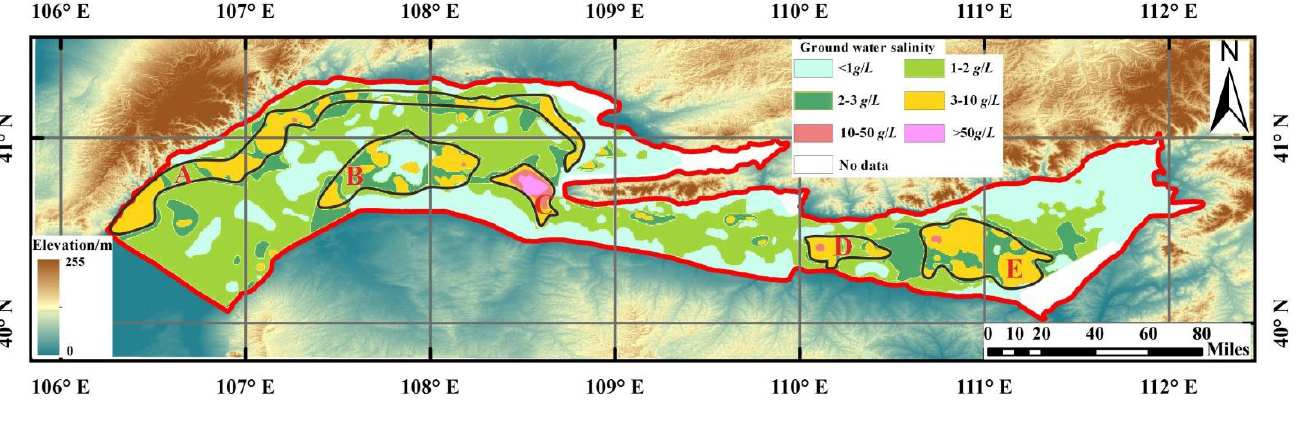
Figure 3. Distribution map of salinity in Hetao Plain. (A — Highly mineralized water distribution zone of valley in front of fan in Houtao Plain; B — Highly mineralized water distribution zone on the north bank of Yellow River in Houtao Plain; C — Highly mineralized water (brine) distribution zone of Xishanzui in Houtao Plain; D — Highly mineralized water distribution zone of Hasuhai in Hubao Plain; E- Highly mineralized water distribution zone of Dalad Banner on the south bank of Yellow River).